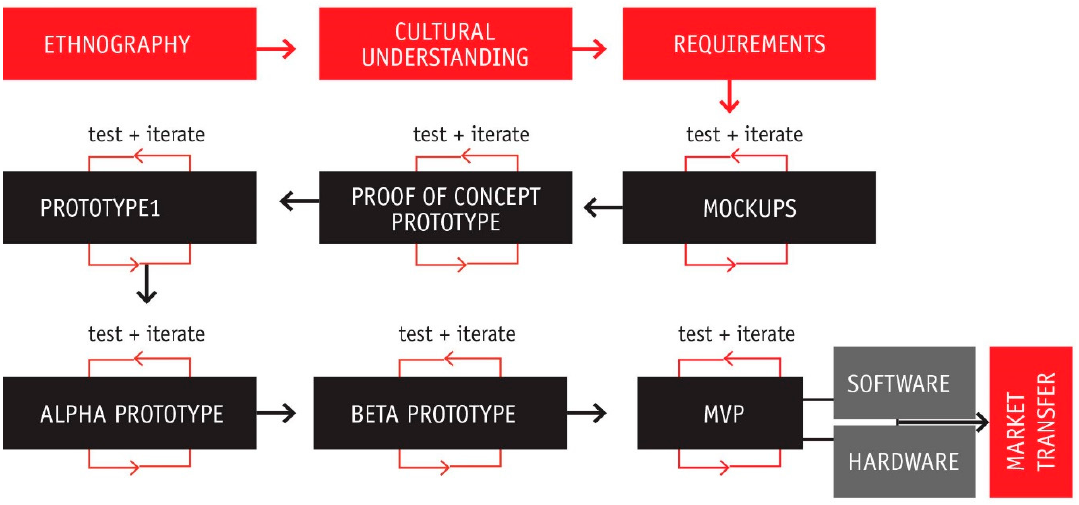
Figure 1. The Anthro-design process based on human oriented research (Miranda, 2019) [17].